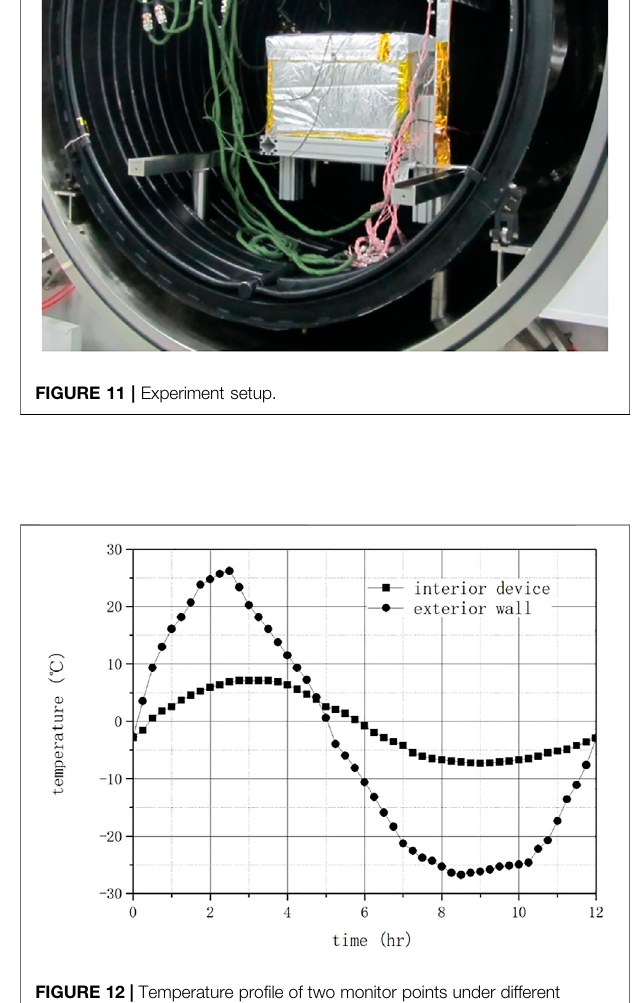
FIGURE 12 | Temperature pro fi le of two monitor points under different heat fl